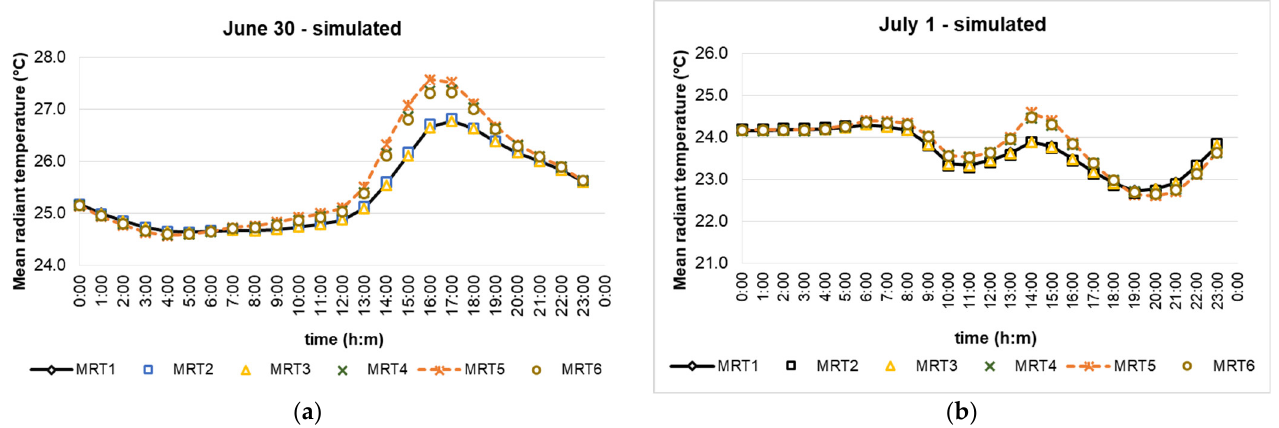
Figure 16. Evaluation of PPD indices from the simulation at different positions in the room (sen01–06): ( a ) for 30 June, ( b ) for 1 July.